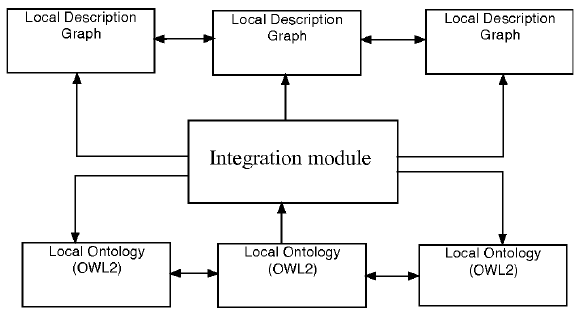
Figure 5. Federation of ontologies in graphs extended knowledge base